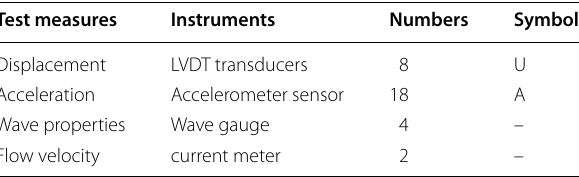
Table 3 Type, number, and symbol of measuring instruments used in the